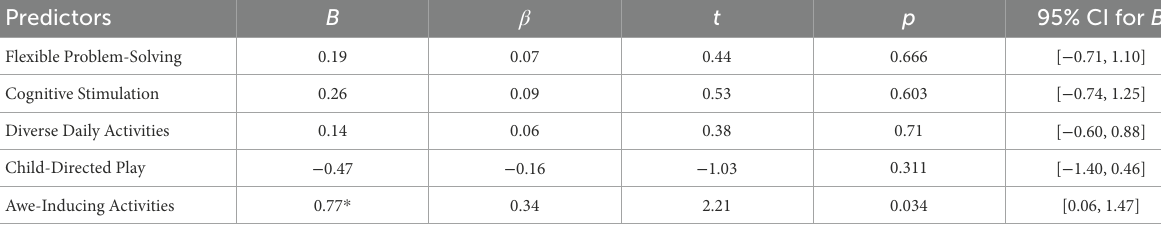
TABLE 7 Multiple regression analysis summary of Caregiver Activity Subscale model.